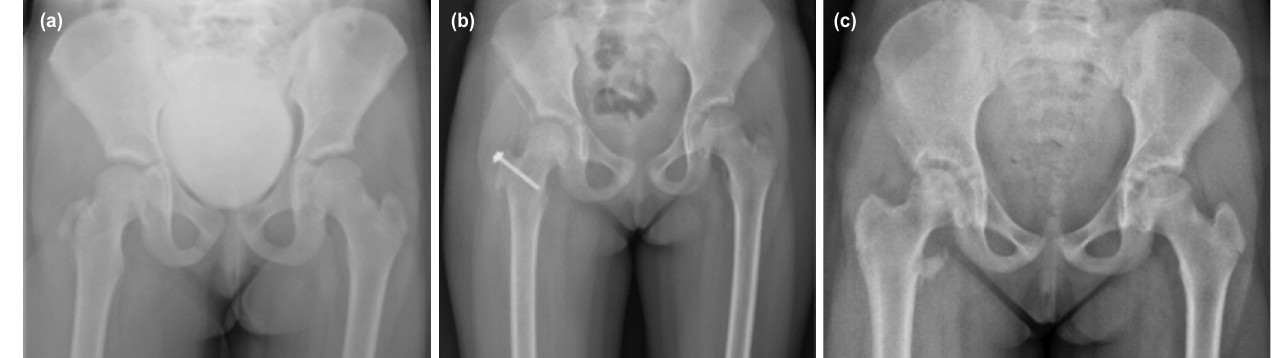
(a) Anteroposterior radiographs of the right hip at the time of presentation, (b) after surgery (c) and after screw removal. Fig. 1: